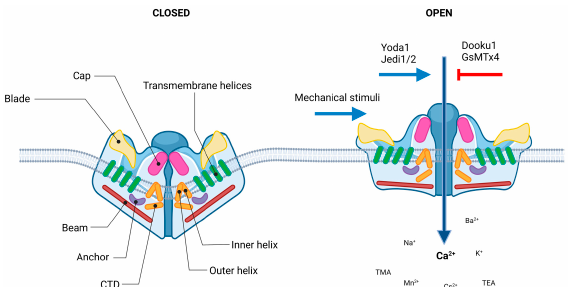
Figure 2 . Piezo1 channel. Structure and regulation of the channel. Piezo1 protein has a homotrimeric architecture with three propeller-shaped blades. The pore consists of the extracellular Cap structure, three pairs of the outer and inner helices (TM domains), and the intracellular C-terminal domain (CTD). The peripheral mechanotransduction region contains the beam structure, the peripheral blade, and the anchor domain (the figure was created using biorender.com).